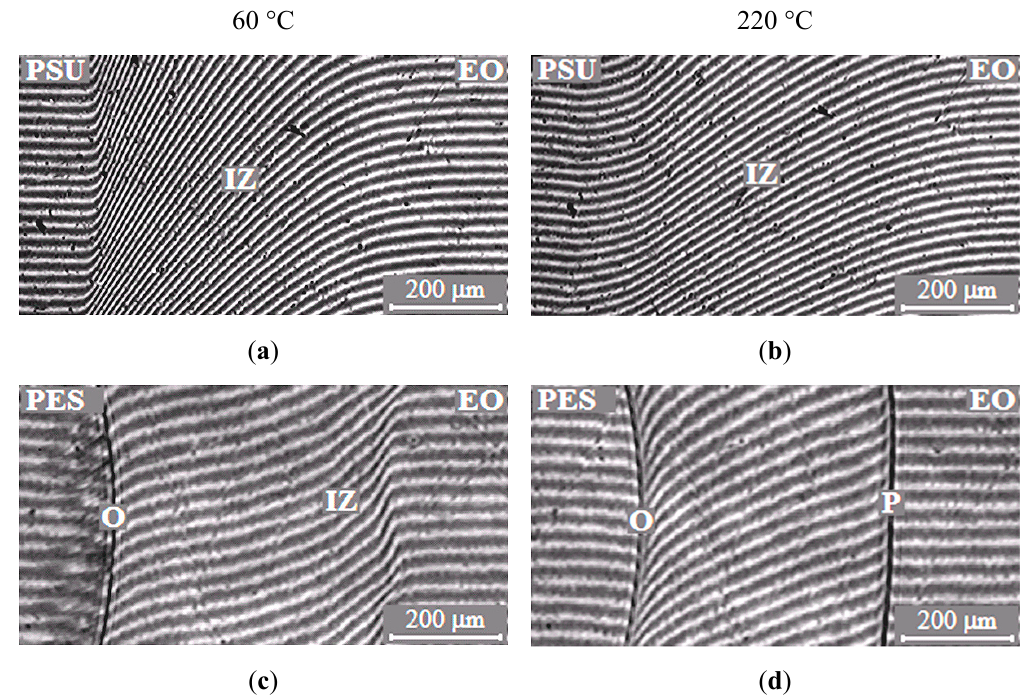
Figure 2. Typical interferograms of interdiffusion zones of the polysulfone (PSU)–epoxy oligomer (EO) systems ( a , b ) and polyethersulfone (PES)–EO ( c , d ) at 60 ( a , c ) and 220 °C ( b , d ). O is the optical boundary, IZ is the interdiffusion zone and P is the phase boundary.